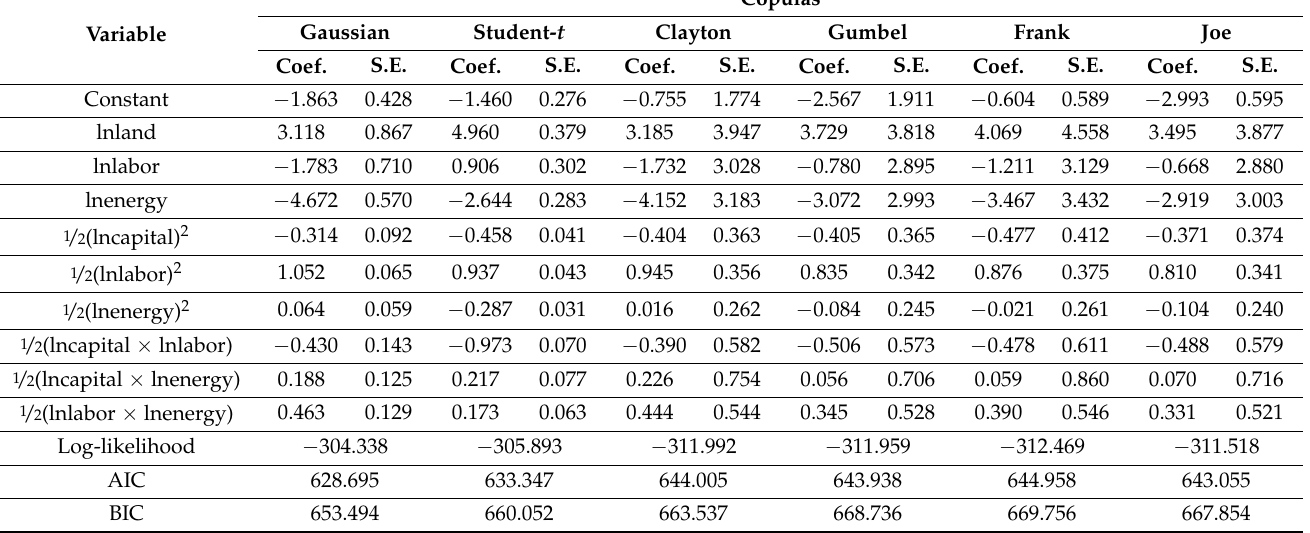
Table 4. Estimated parameters and standard errors for the meta-frontier model based on six different copula